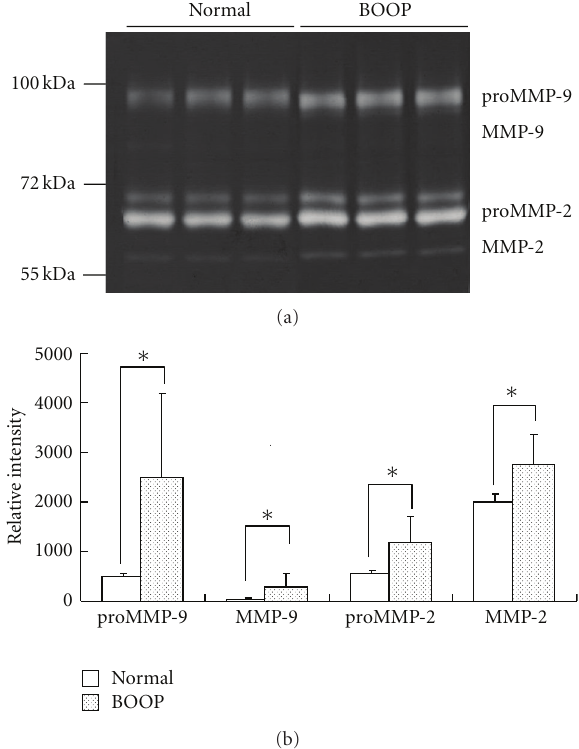
Figure 4: Metalloproteinase activity in BOOP tissues. The gelatin zymography revealed MMPs activity from three representative BOOP and normal pigs (a). For each individual BOOP or normal pig, six sample lung sections were evaluated for MMP activity and averaged. Then, the averages from the BOOP and normal animals were pooled from the five di ff erent pigs to generate the data presented (b). The activities of proMMP-9, MMP-9, proMMP-2, and MMP-2 were all significantly increased in BOOP group ((b), P < . 05). ∗ P < . 05 versus normal group ( n = 5, six replicates in each individual